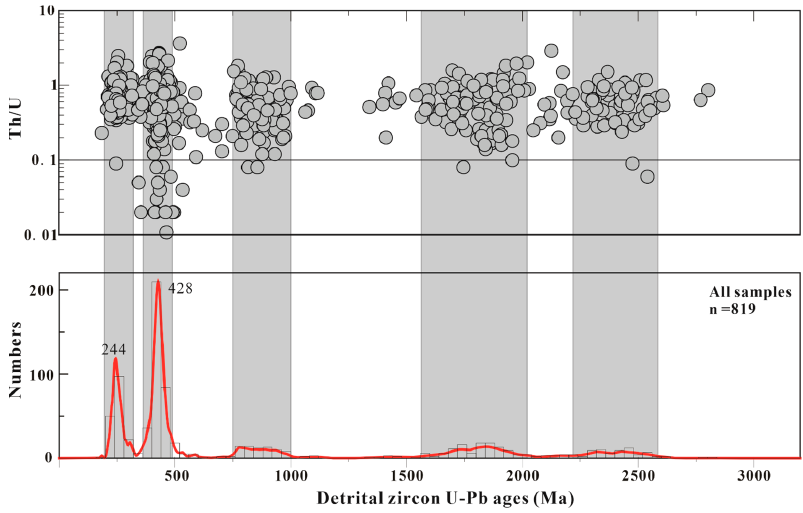
Figure 5. The Th/U ratios and detrital zircon ages of all analyzed samples. Figure 5. The Th / U ratios and detrital zircon ages of all analyzed